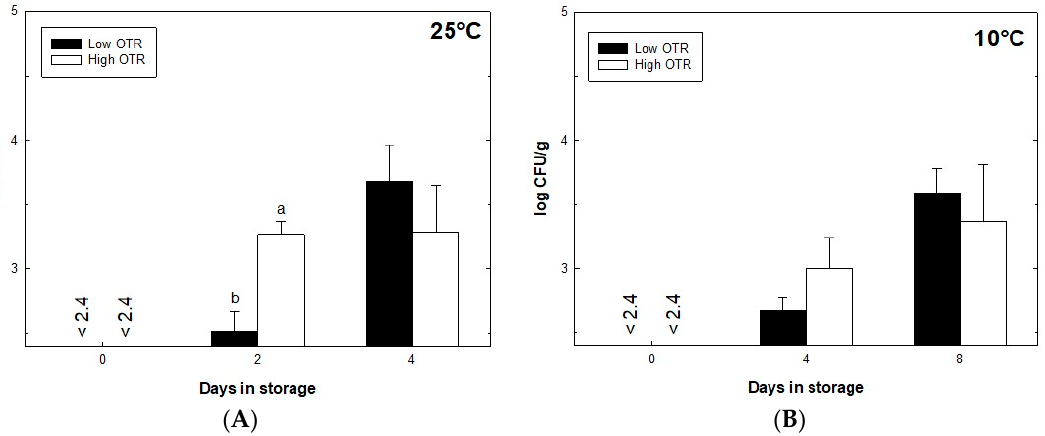
Figure 2. The number of mesophilic bacteria in ‘Pione’ grapes stored in passive MAP with low and high-OTR films at 25 ◦ C for 4 days ( A ) and 10 ◦ C for 8 days ( B ). Less than 2.4 log CFU/g means below the level of detection. Vertical lines represent the standard error of the mean ( n = 3). Bars with different letters indicate significance at p ≤ 0.05 between paired low and high-OTR